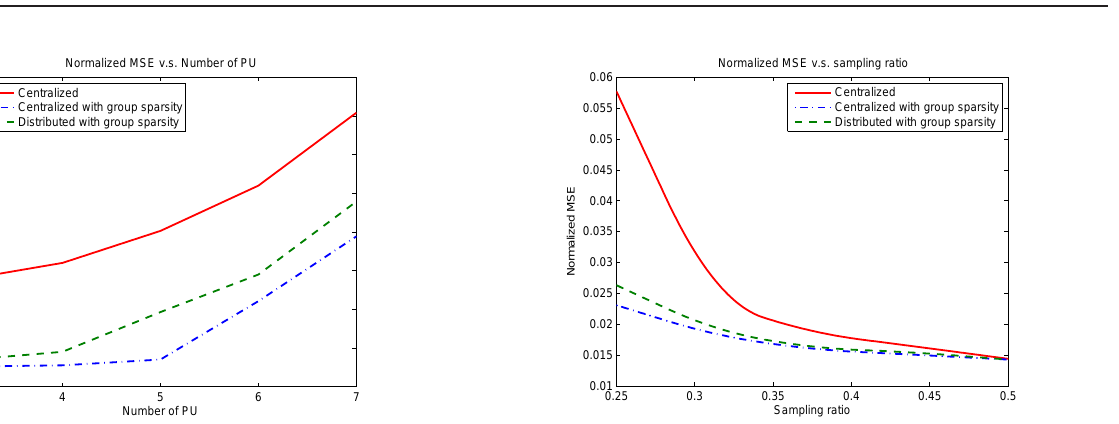
Figure 5. Normalized MSE of spectrum estimation